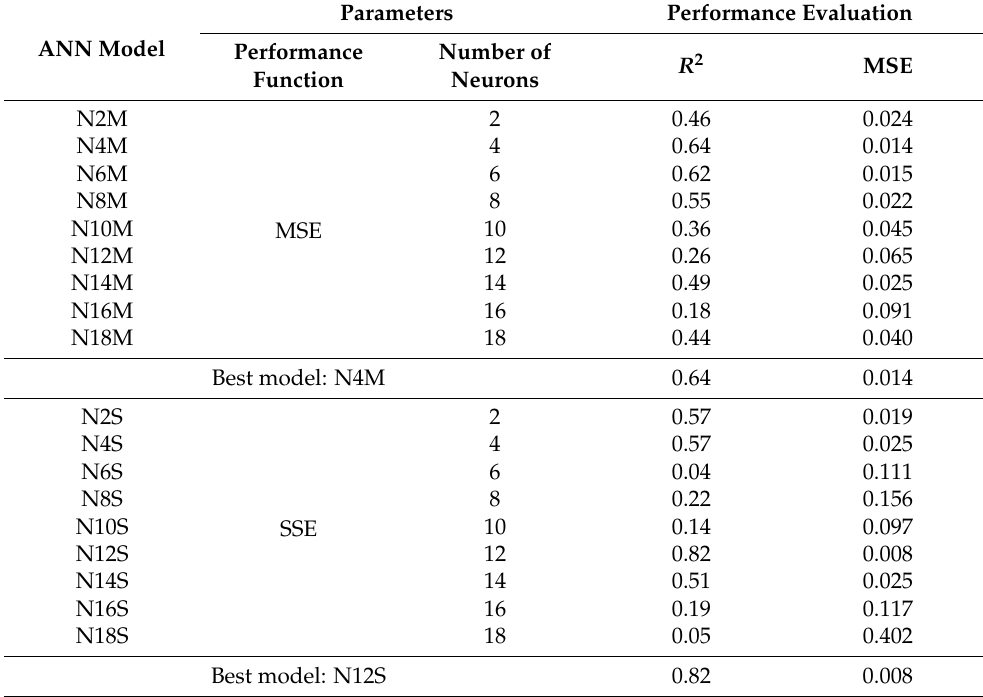
Figure 9. Schematic diagram of ANN model. Table 6. Performance of ANN